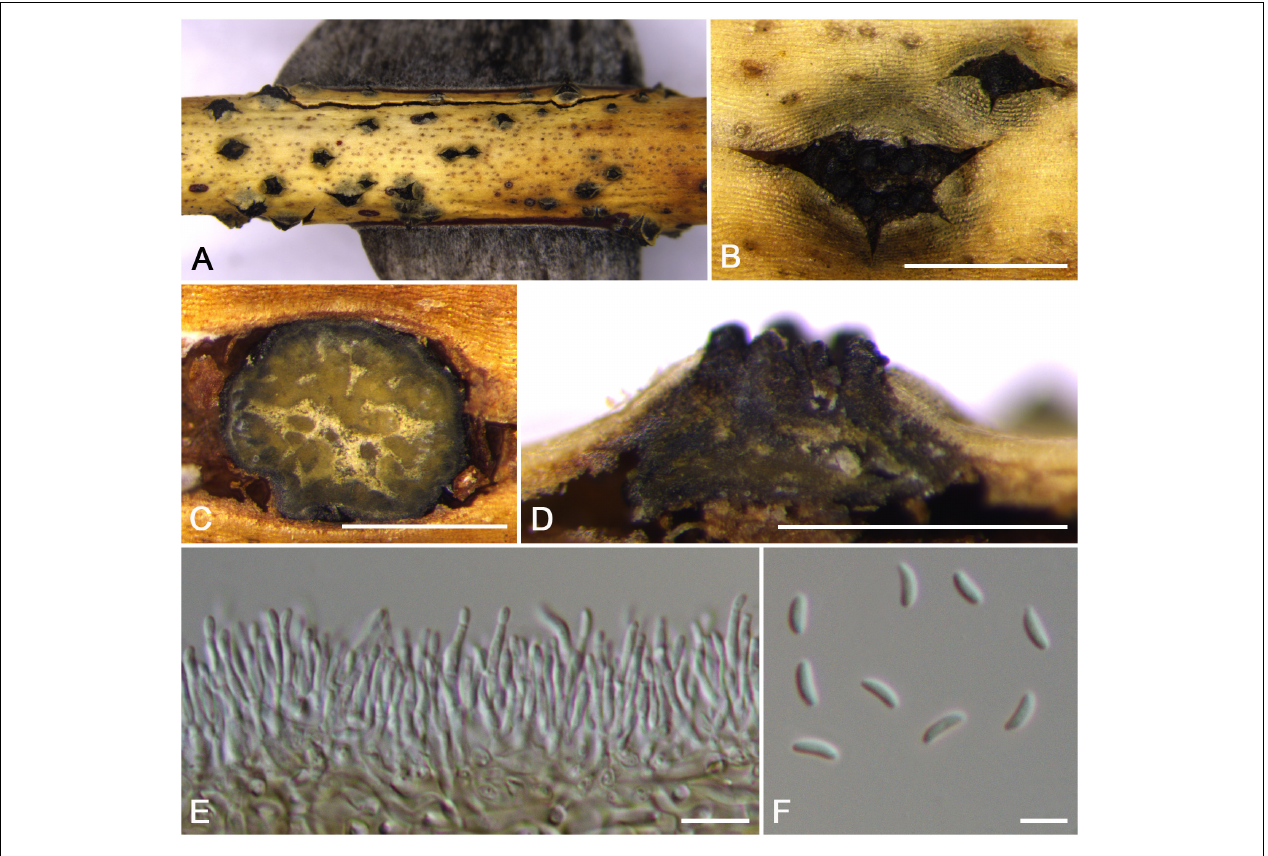
FIGURE 11 | Morphology of Cytospora rosicola from Rosa sp. (CF 20197024). (A,B) Habit of conidiomata on twig. (C) Transverse section of conidioma. (D) Longitudinal section through conidioma. (E) Conidiophores and conidiogenous cells. (F) Conidia. Bars: (B–D) = 500 µ m; (E) = 10 µ m; (F) = 5 µ m.